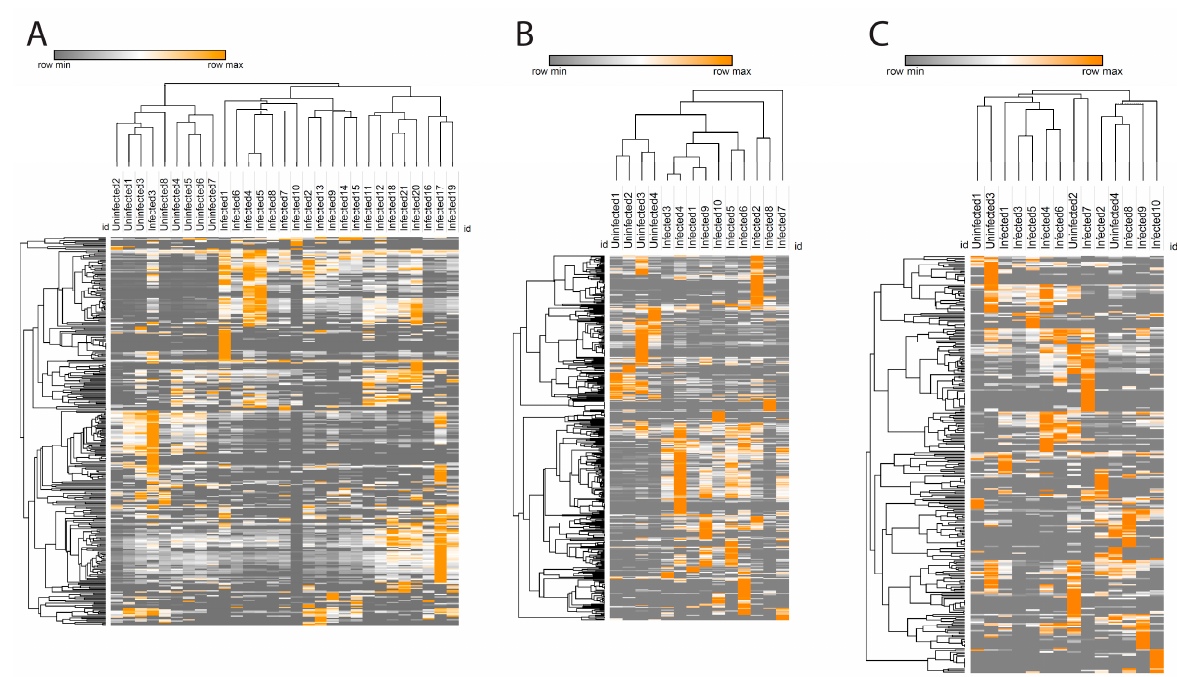
Figure 3. Glycerophosphocholines heat map in spleen ( A ), liver ( B ), and gut ( C ). Each column repere- sent one sample and each row represents one metabolite feature from the glycerophosphocholine family. Color scheme shows the minimum (gray) and maximum (orange) values in each row.